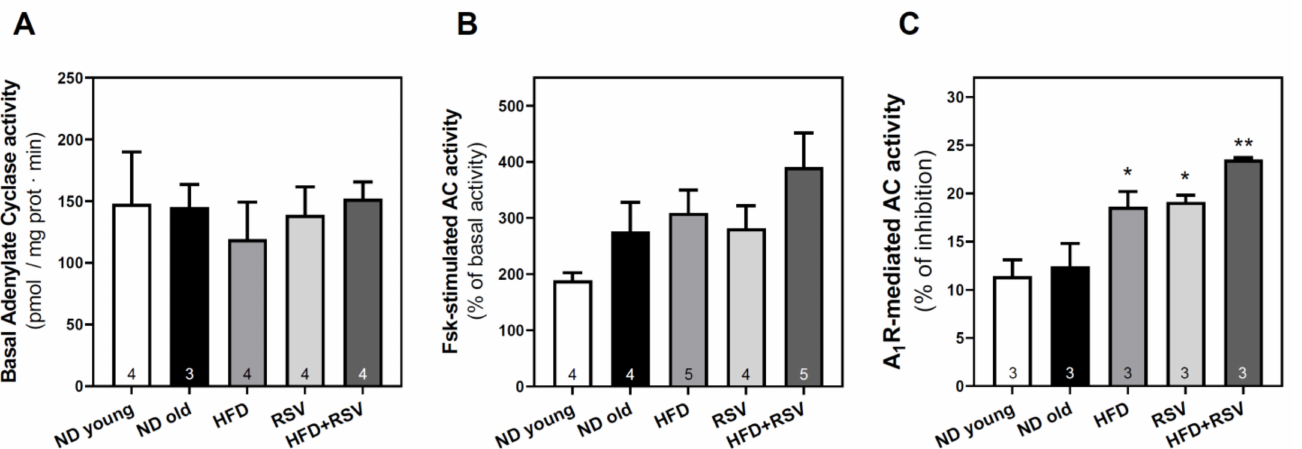
Figure 5. Adenylyl cyclase activity in the cerebral cortex of C57BL/6J mice. Basal ( A ), forskolin (Fsk)-stimulated ( B ) and A 1 R-mediated ( C ) adenylyl cyclase activities were measured in the plasma membrane fraction of the cerebral cortex of C57BL/6J mice. Data are mean ± SEM of three-five different samples (indicated within the bars). * p < 0.05 and ** p < 0.01 significantly different from ND-old group (panel C ) according to one-way ANOVA.